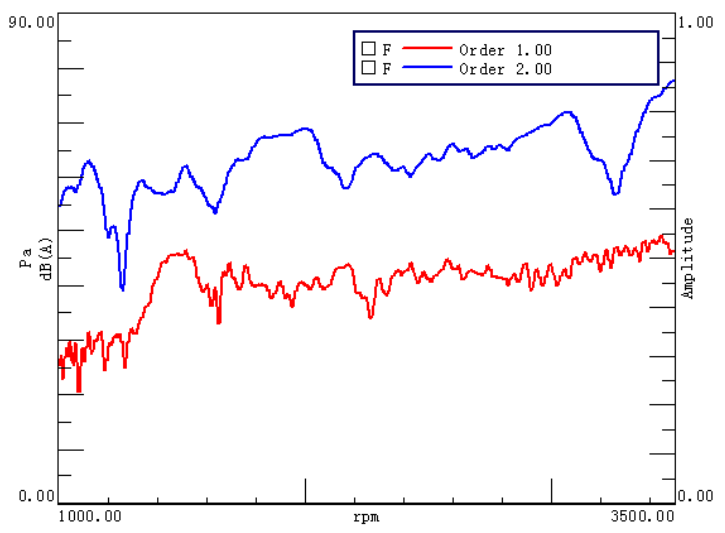
Figure 8. Order harmonic slicing curve.